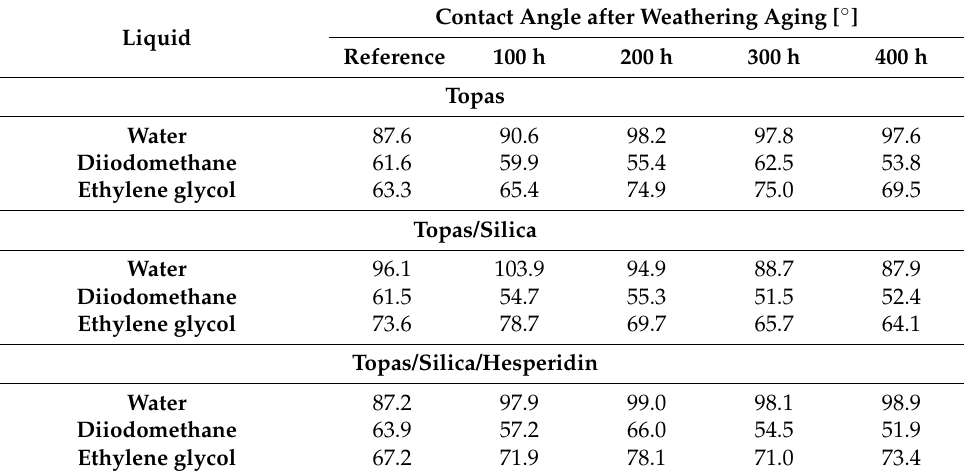
Figure 1. Changes in surface free energy (SFE) of Topas blends include the results before and after 100, 200, 300 and 400 h of aging, respectively. Table 1. Contact angle values determined by using distilled water, ethylene glycol, and 1,4- diiodomethane for Topas mixtures before and after weathering